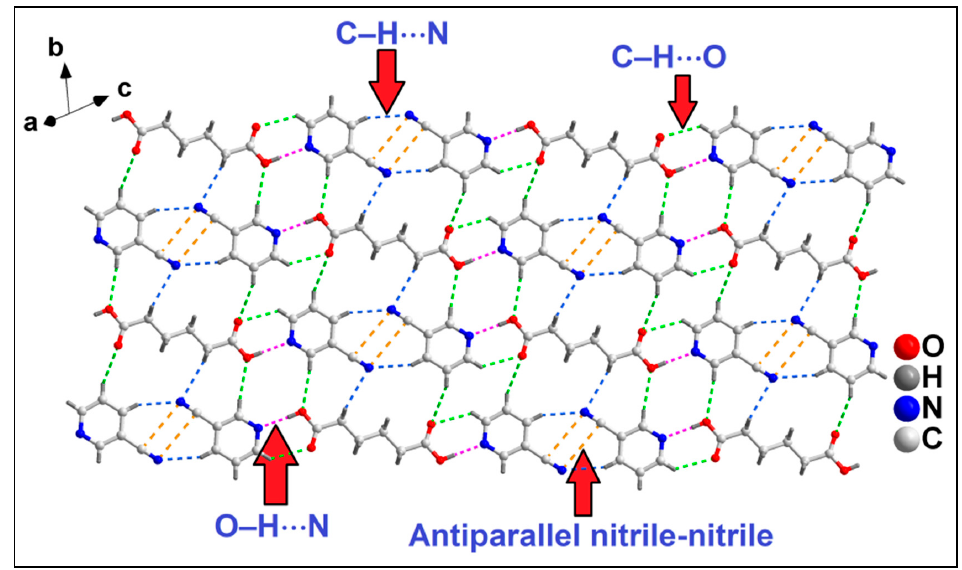
Figure 5. Layered assembly of co-crystal 4 along the crystallographic bc plane assisted by antipar-